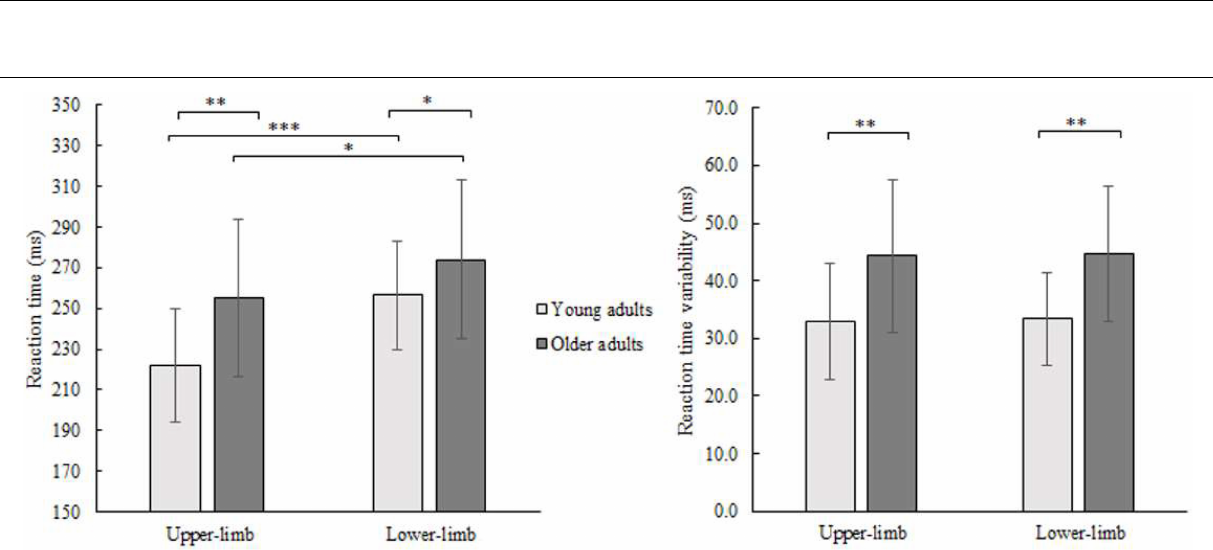
Frontiers in Aging Neuroscience |